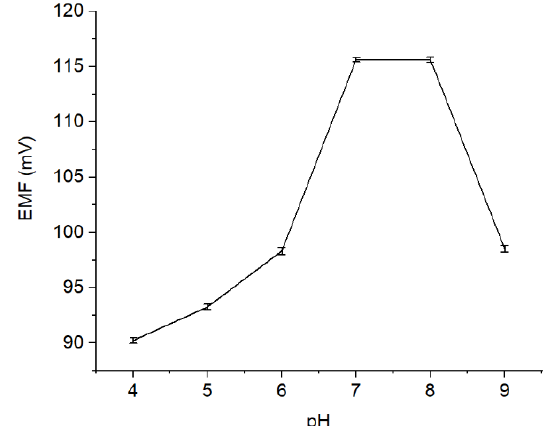
Figure 5. Potential curve (mV) measured on different pH levels (pH